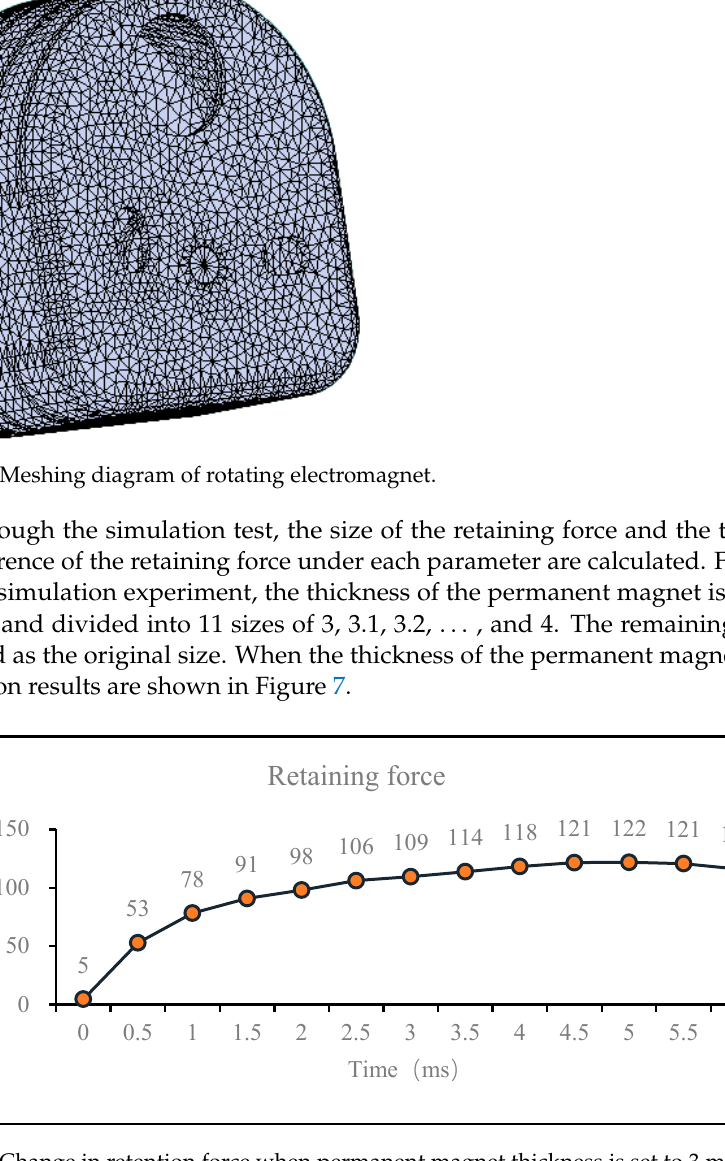
Figure 7. Change in retention force when permanent magnet thickness is set to 3 mm . Similarly, the other simulation results are obtained and shown in Table 9. The codes in Table 9 have the same meaning as those in Table 7. In Table 9, the force refers to the holding force of the electromagnet under the specified conditions. For example, in Table 9, the holding force in the second row is the result under the parameter A in the first row. In Table 9, the unit of the distance is mm, the unit of the angle is degrees, and the unit of the holding force is N . Then the absolute value of the difference between the holding forces under each parameter is calculated, which is the holding force after the parameter changes minus the minimum holding force in the parameter. The calculation results are shown in Table